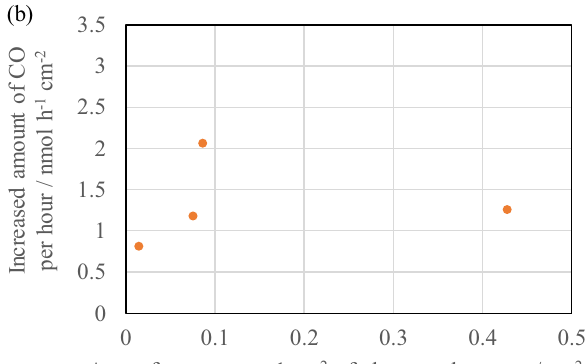
Fig. 15 Relationships between the Au surface area per 1 nm 2 pho- tocatalyst area and the amounts of a CH unit